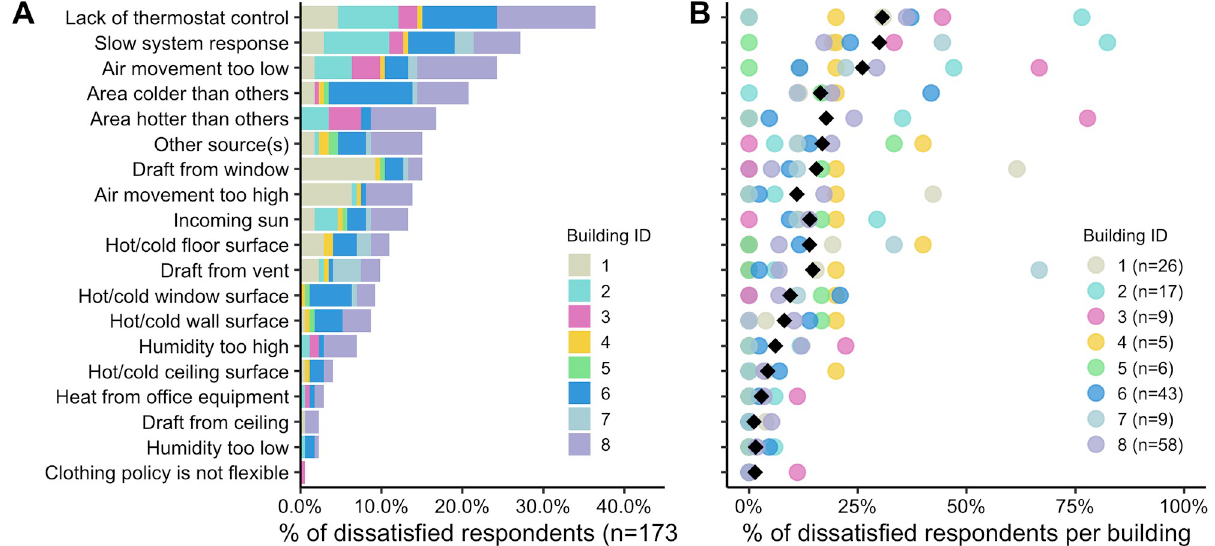
Fig 2. (A) Percentage of dissatisfied occupants across all eight buildings (n = 173), and (B) percentage of dissatisfied occupants per building for each of the 19 potential sources of thermal discomfort (n by building). The black diamond represents the average percent dissatisfied across each of the individual